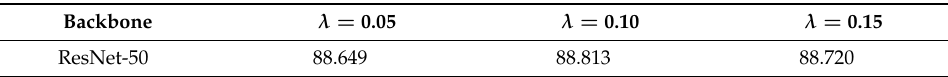
Table 7. Ablation study on the hyper-parameter λ .